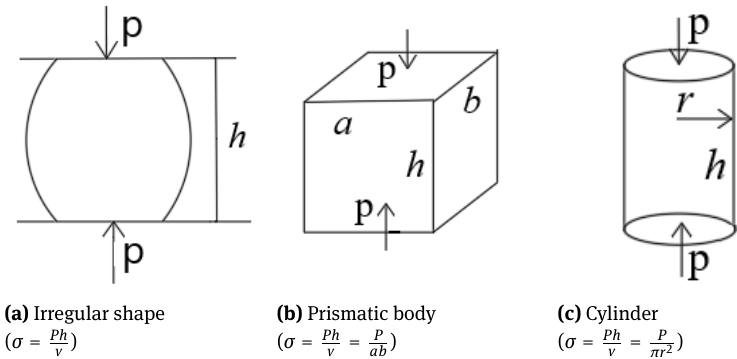
Figure 3: Different types of shape estimation methods (V is the volume of